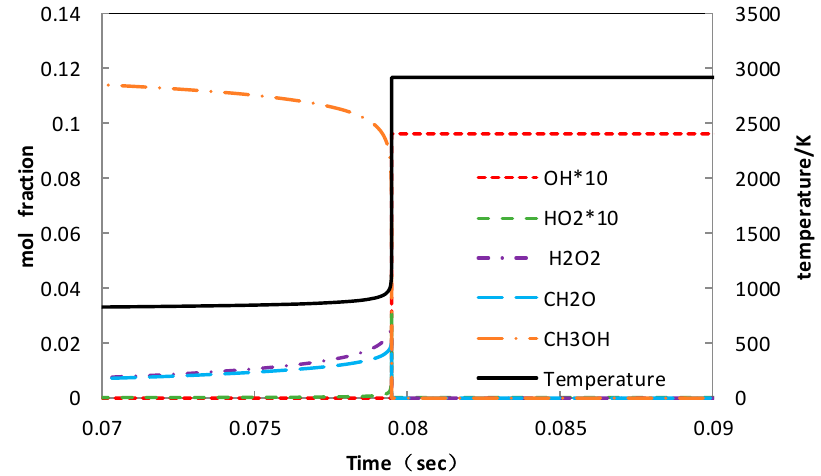
Figure 5. The mol fraction and temperature curve of methanol and its important free radicals.